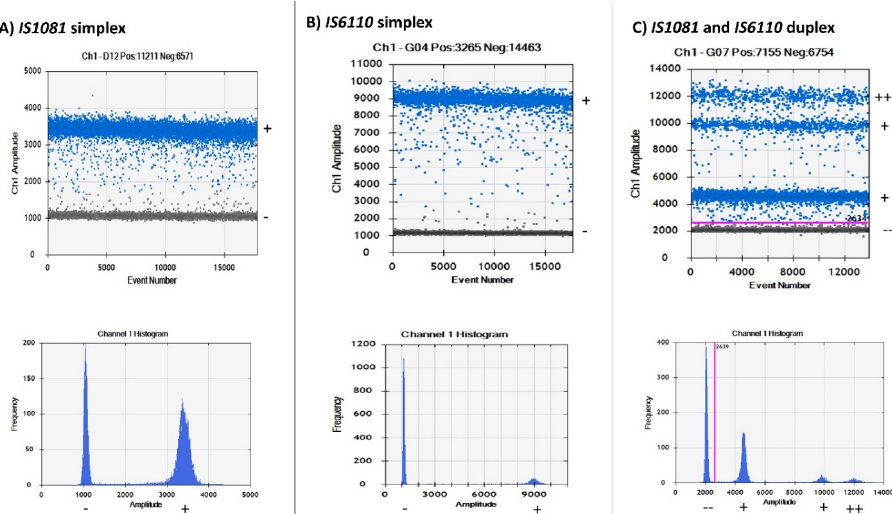
Figure 2. Channel 1 and histogram results for droplet separation based on simplex and duplex assays. ( A ) Droplet separation based on the IS1081 simplex assay results. Positive droplets were observed at an amplitude of about 3500 while negative droplets were observed at an amplitude of about 1000. ( B ) Droplet separation based on the IS6110 simplex assay results. Positive droplets were observed at an amplitude of about 9000 while negative droplets were observed at an amplitude of about 1000. ( C ) Droplet separation based on a duplex assay containing primers for both IS6110 and IS1081 genes. Four droplet partitions observed with double negative droplets at an amplitude of about 2000, IS1081 droplets at an amplitude of about 4500, IS6110 droplets at an amplitude of about 10,000, and double positive droplets at an amplitude of about 12,000. (−) negative droplets, (+) positive droplets, (++) double positive droplets, (− −) double negative droplets.